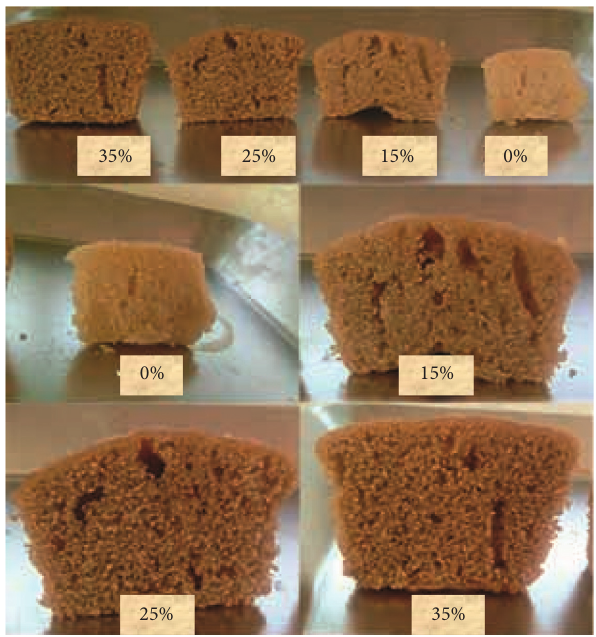
Figure 1: Cross section of sponge cakes containing 0% (control), 15, 25, and 35%